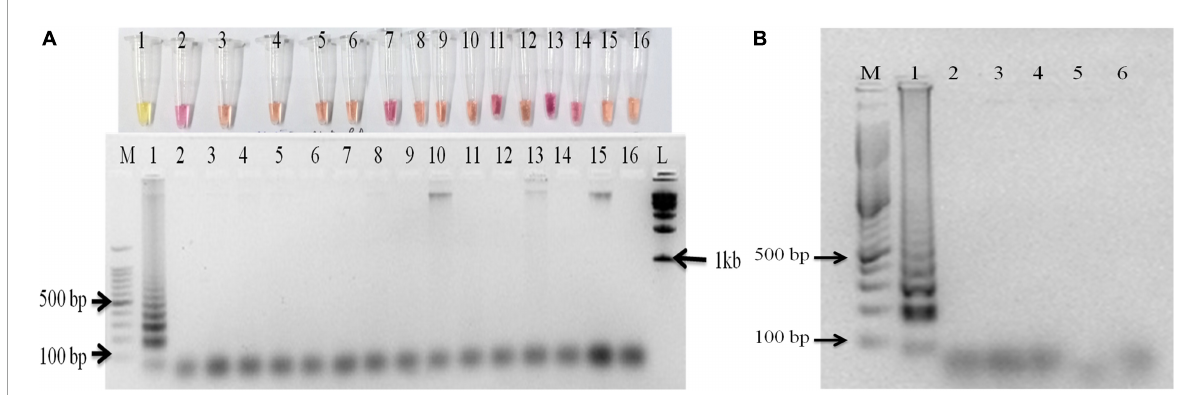
FIGURE2 Specificity assay of the LAMP assay. (A) M: 100 bp (Promega); 1: S. oryzae NAIMCC-F-01630; 2: Rhizoctonia solani AG-1 IA isolate NAIMCC-F-03220; 3: R. solani AG-1 IB isolate M2; 4: R. solani AG 2-2IIIB isolate O1; 5: R. solani AG-8 isolate S1; 6: Magnaporthe oryzae isolate MG1; 7: R. oryzae-sativae isolate MTCC-9666; 8: Fusarium fujikuroi NAIMCC-F-03979; 9: Sclerotinia sclerotiorum NAIMCC-F-03341; 10: Trichoderma asperellum NAIMCC-F-03330; 11: F. oxyporum f. sp. lycopersici ; 12: Alternaria alternata isolate NAIMCC-F-00067; 13: Ustilaginoidea virens NAIMCC-F-02995; 14: Helminthosporium oryzae NAIMCC-F-03040; 15: Pseudomonas plecoglossicida NAIMCC-B-00397; 16: No Template control; (upper panel: gel photograph; lower panel: colorimetric reactions in PCR tubes). (B) M: 100 bp (Promega); 1: S. oryzae NAIMCC-F-01631; 2: S. implicatum RPF 22 NAIMCC-F-04128; 3: Acremonium curvulum CABI-297016 NAIMCC-F-00022; 4: S. kiliense ATCC-14491/CABI-090242 ( A. kiliense ) NAIMCC-F-00028; 5: S. strictum ATCC-18941 CABI-230422 ( A. strictum ) NAIMCC-F-00053; and 6: No Template